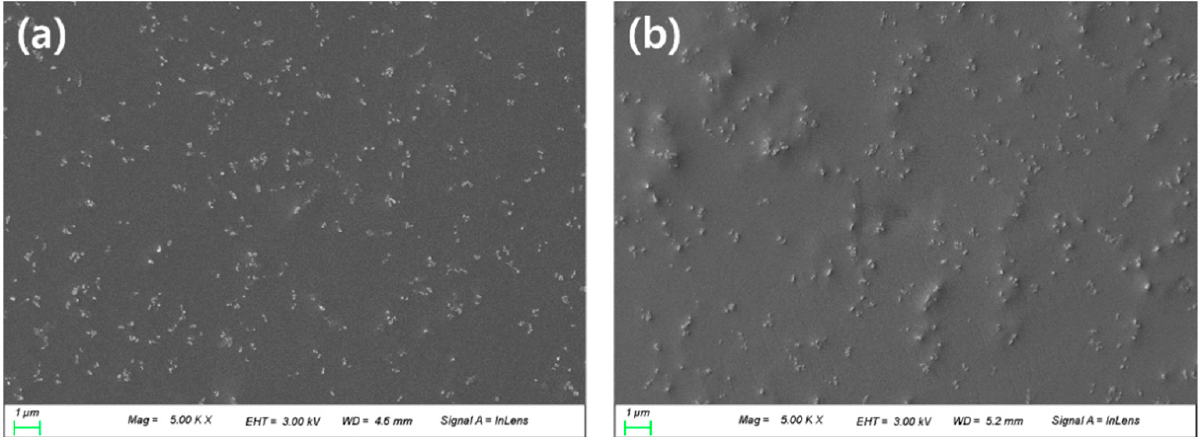
Figure 6. SEM analysis of ( a ) PN sample and ( b ) PNM3 sample.